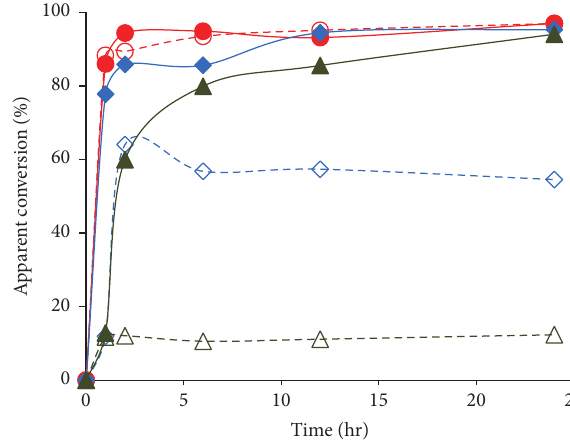
Figure 3: Apparent conversion versus polymerization time in AIBN-initiated, deoxygenated admicellar polymerization (“solid red circle” M/I of 15; “solid blue diamond” M/I of 150; “solid green triangle” M/I of 1000) and control admicellar polymerization (“vacant red circle” M/I of 15; “vacant blue diamond” M/I of 150; “vacant green triangle” M/I of 1000). Lines are drawn solely to guide the